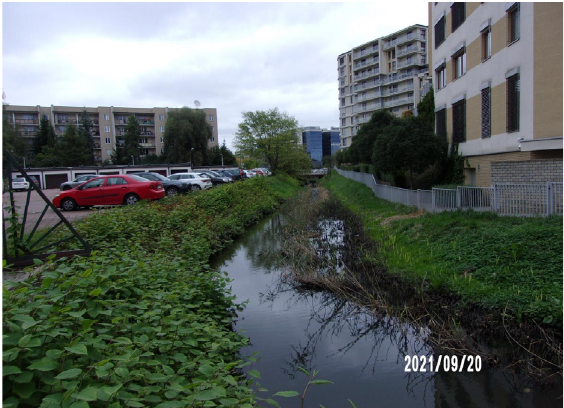
Figure A14. Elevated water level of the S ł u ż ewiecki Brook at Wy ś cigowa Street (source: own).